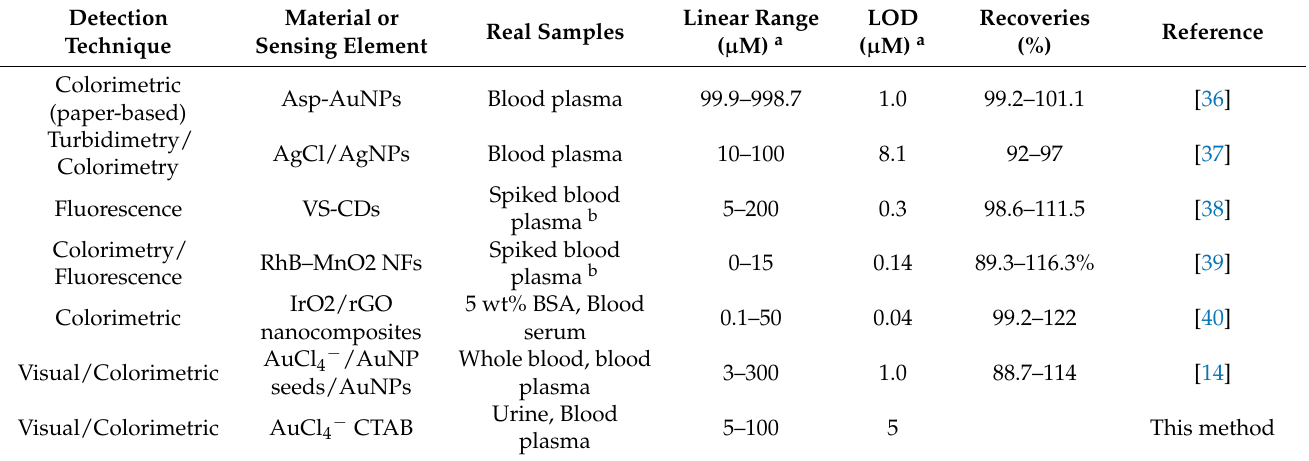
Table 2. Comparison of the method with recent methods for the determination of